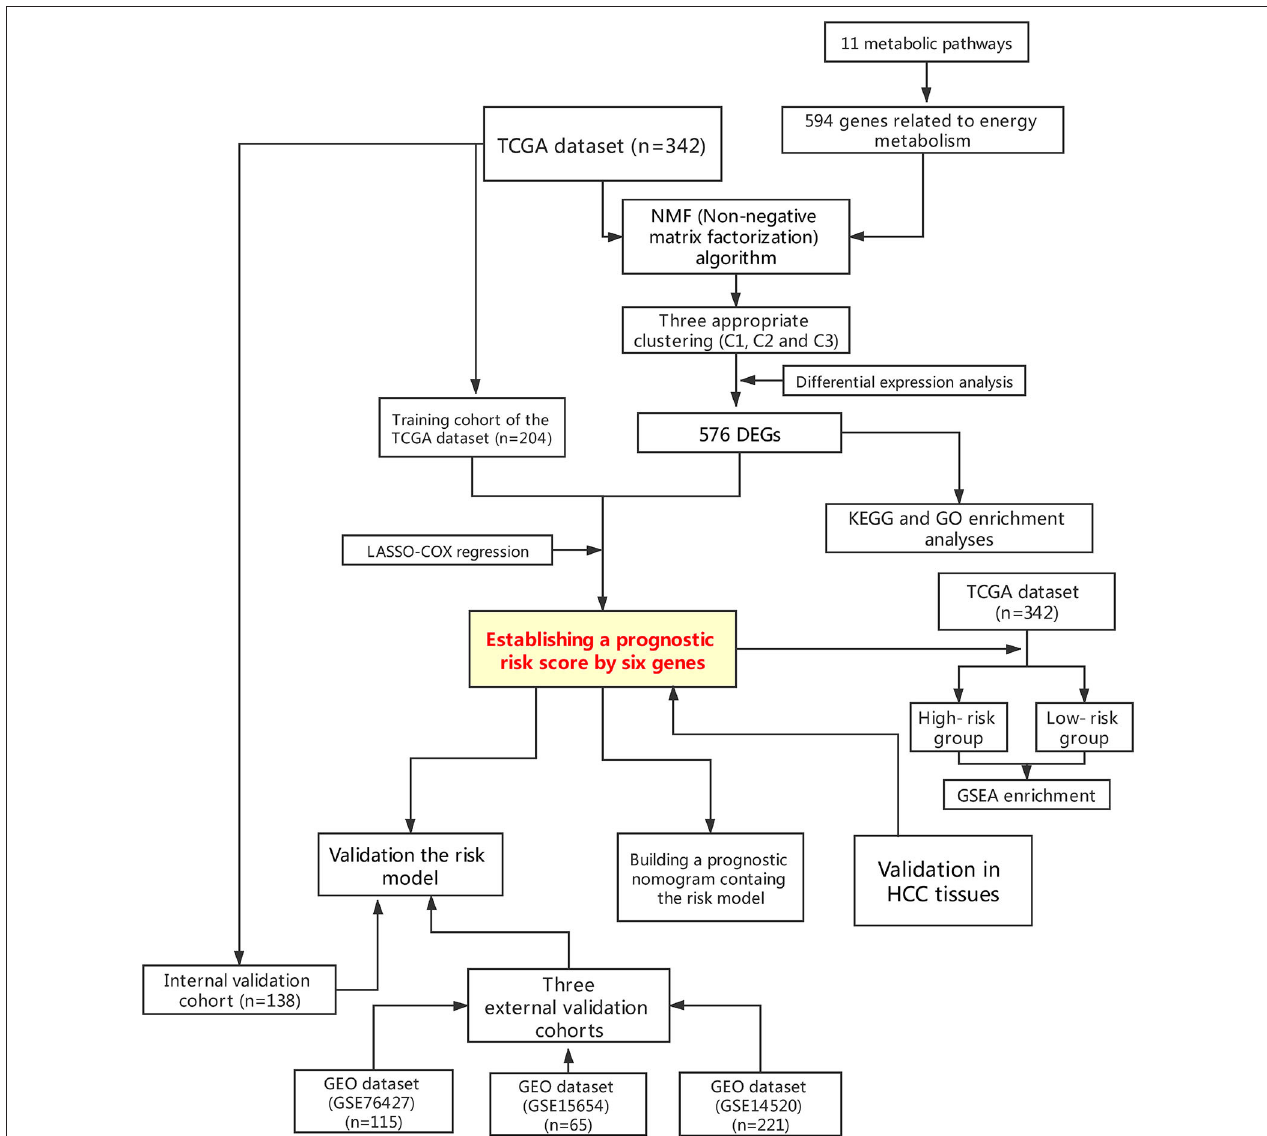
FIGURE 1 | Flowchart presenting the process of establishing the gene signature and prognostic nomogram of pancreatic cancer in this